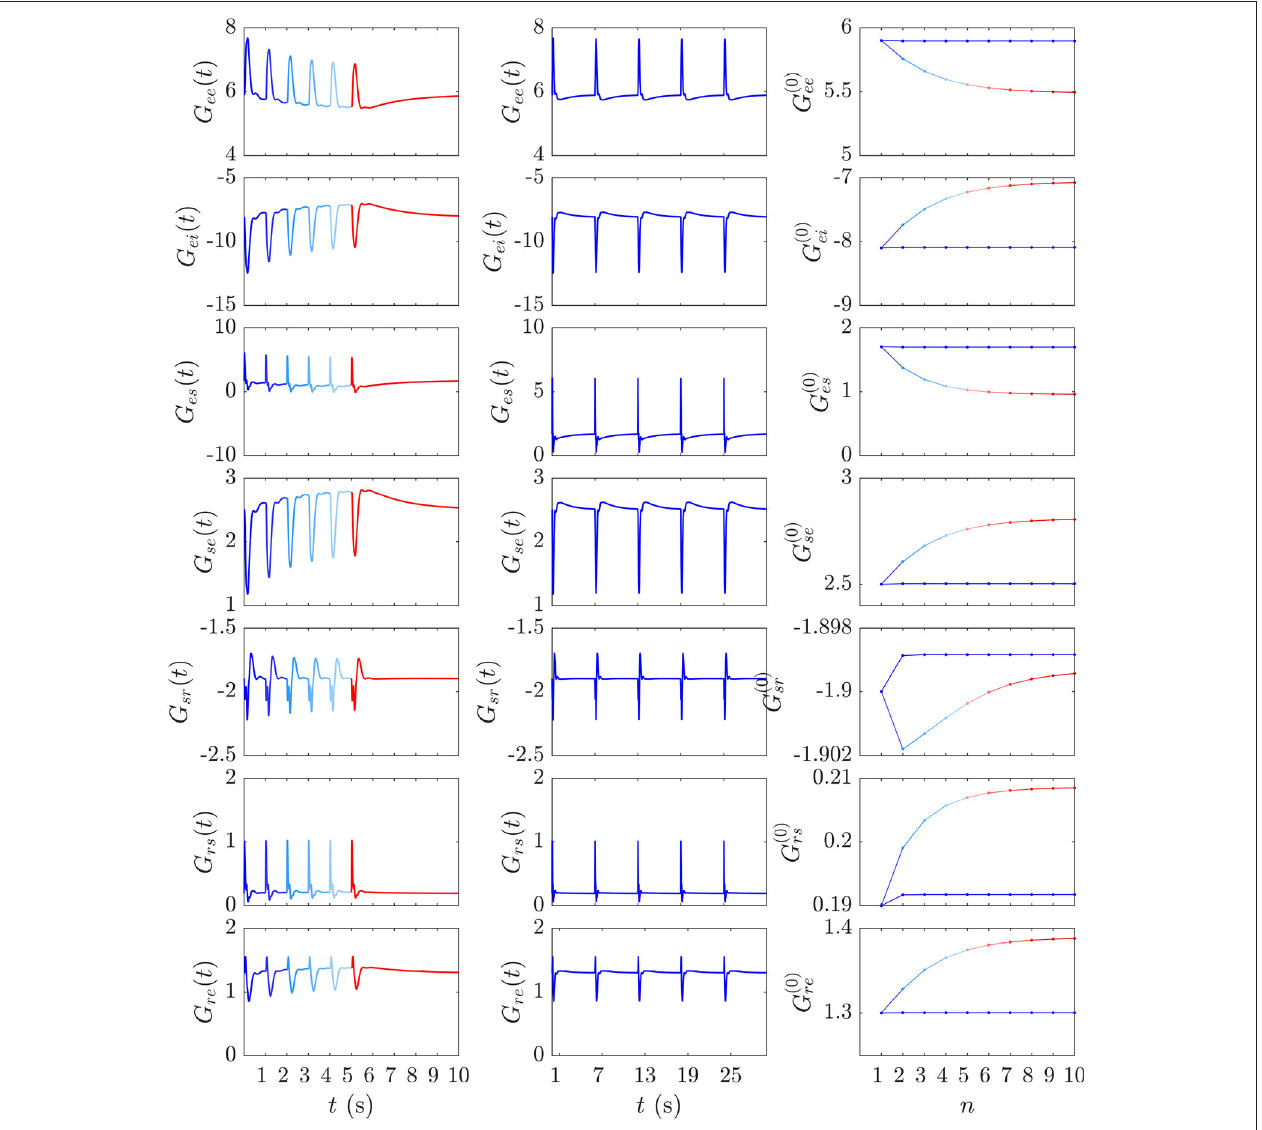
FIGURE 7 | Evolution of the instantaneous G ab ( t ) and prestimulus G (0) ab gains corresponding to the two cases from Figures 6A,B . The first and second columns show the gain evolution G ab ( t ) during the development of the S response (blue to red) and the successive D responses (blue), respectively. The third column depicts the ∞ corresponding pre-stimulus gains G (0) ab immediately prior to the successive S and D stimuli vs. stimulus number n